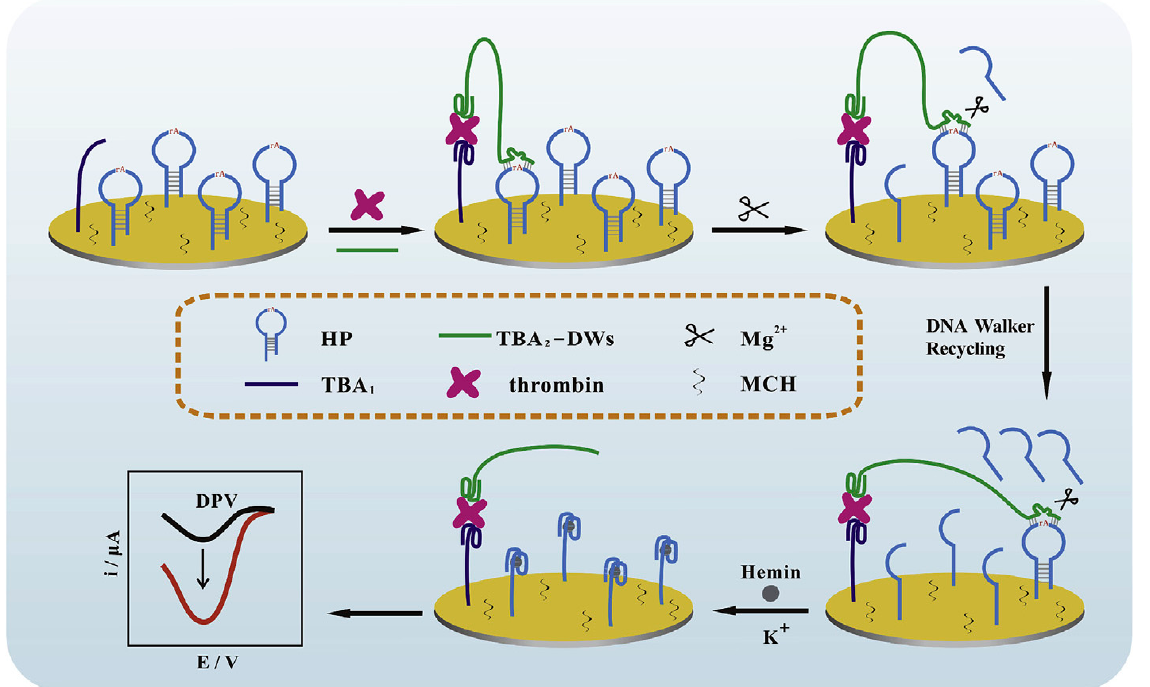
Figure 1. An electrochemical aptasensor based on the DNA walker amplification strategy for TB determination